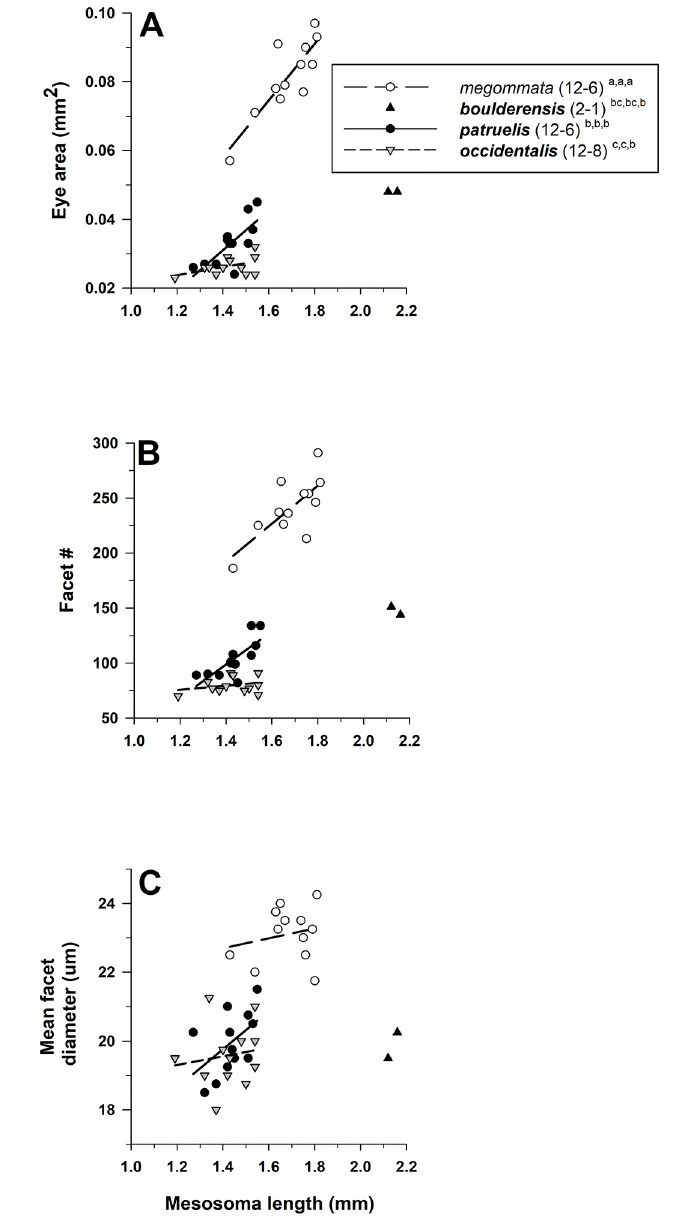
Fig 7. Eye area (mm 2 ) (A) , facet number (B) , and mean facet diameter ( D ) ( μ m) (C) for species of Aphaenogaster (subfamily Myrmicinae: tribe Stenammini). Aphaenogaster megommata is pale (open symbols and regular font), while A . boulderensis , A . occidentalis , and A . patruelis are dark (filled symbols and bold font) (see text). For each species, number of workers examined and number of colonies they were derived from is given in parentheses. Significant differences ( P < 0.05) among species are denoted after each species name by the letters a–c : a > b > c ; the three sets of letters for each species correspond to panels A, B, and C, respectively. Groupings are based on univariate F tests within MANCOVA using the estimated marginal means followed by pairwise comparisons using a least significant differences test (see text).